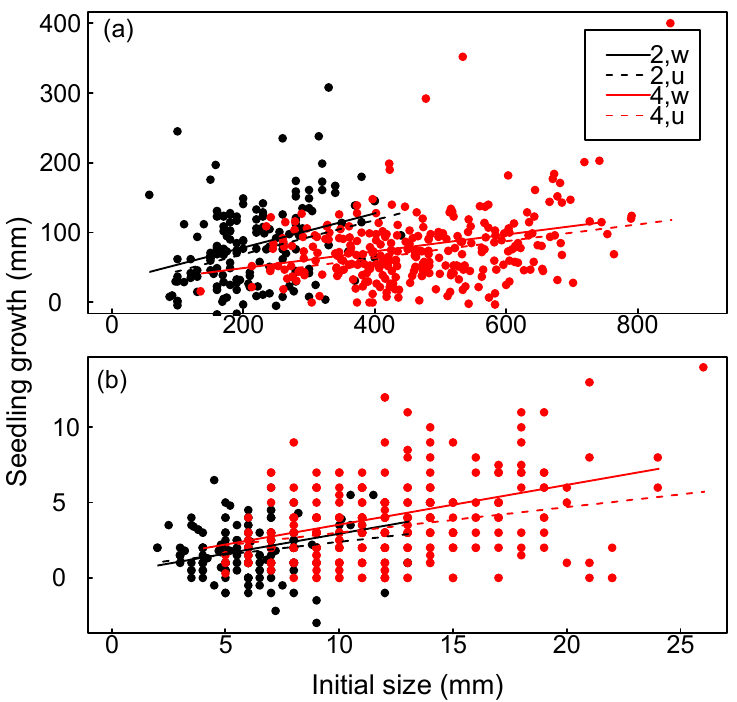
Figure 4. Effects of weeding on seedling growth in ( a ) stem height and ( b ) stem width. The lines are drawn from the parameters of a model with all significant terms included, averaged over landscape units. w = weeded; u = unweeded; 2 and 4 indicate seedling age.